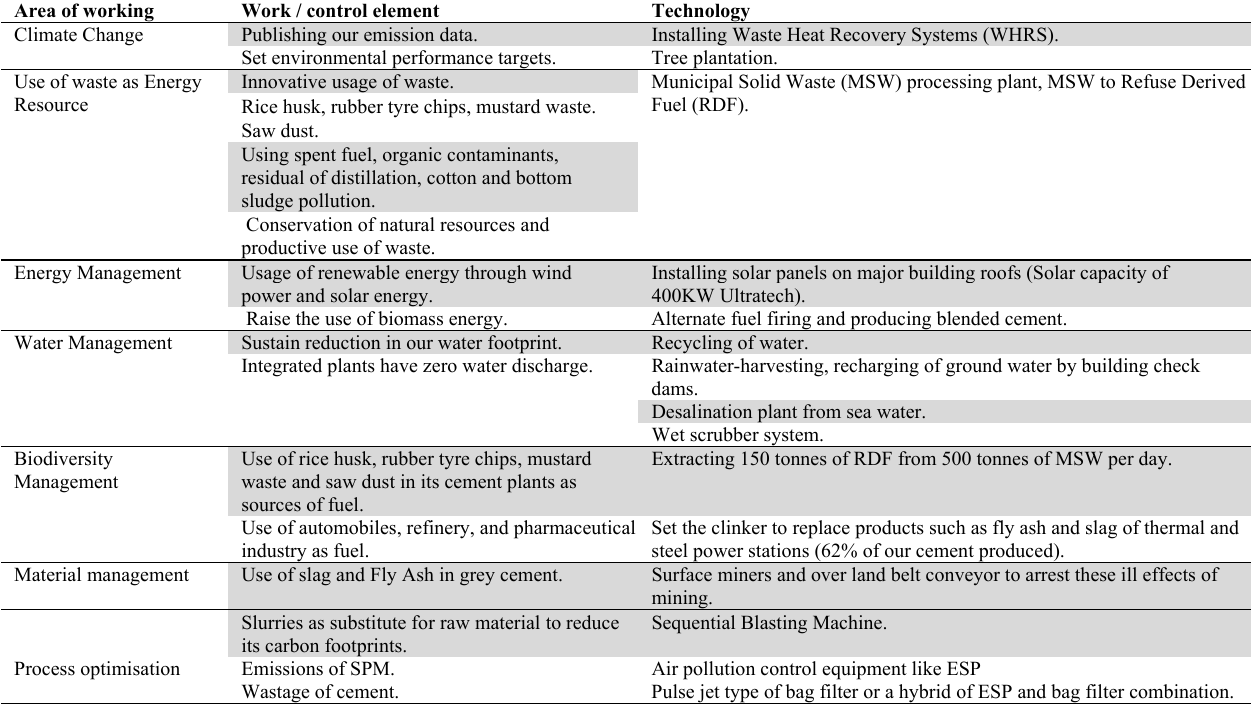
Snapshot of technology use by cement